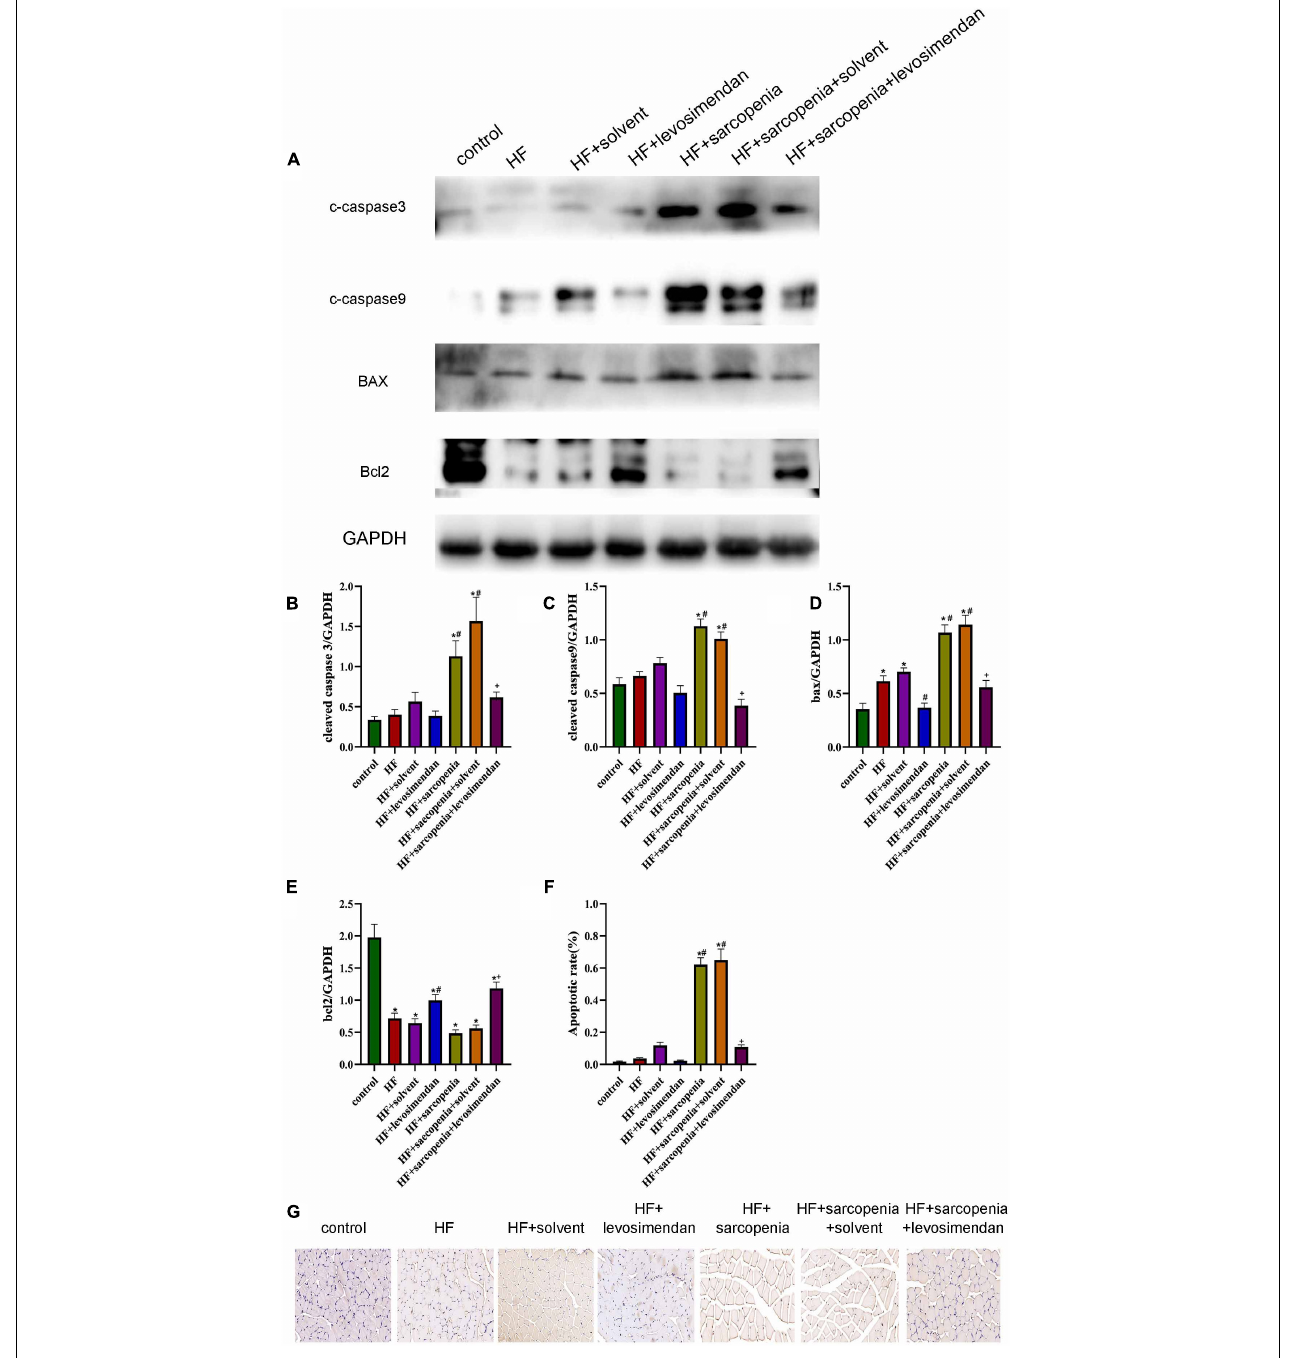
FIGURE 6 | Levosimendan improves skeletal muscle apoptosis (A) detection of cleaved caspase-3, cleaved caspase-9, Bax and Bcl2 expression through western blotting; GAPDH: internal reference. (B–E) Relative protein expression levels of cleaved caspase-3, cleaved caspase-9, Bax and Bcl2. (F) Apoptotic rate (%) of TUNEL staining. (G) TUNEL staining of gastrocnemius. N = 5–12. * P < 0.05 vs. control, # P < 0.05 vs. HF, + P < 0.05 vs. HF + sarcopenia. Bar = 40 µ m.